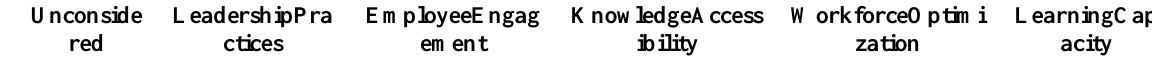
Table 4. Sensitivity